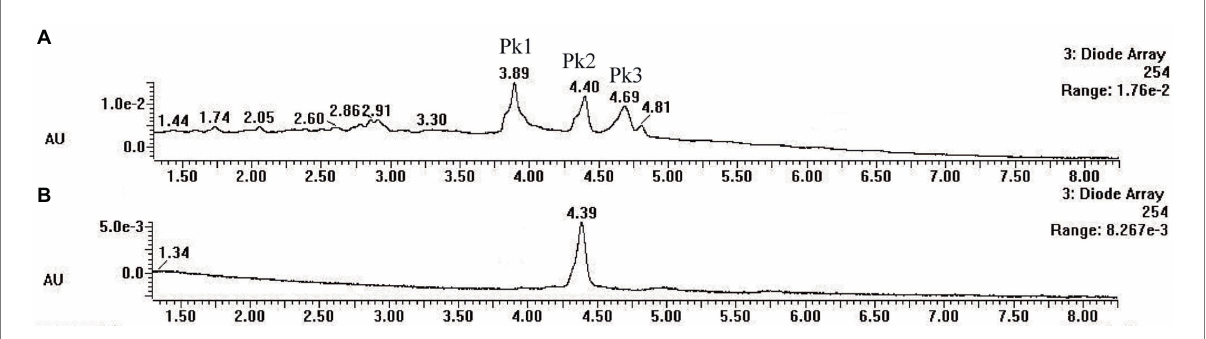
FIGURE 4 HPLC analysis of pigment extracts of strain SYBC-L7. (A) HPLC chromatograms of pigment extracts of strain SYBC-L7; (B) HPLC chromatograms of CA standard sample.